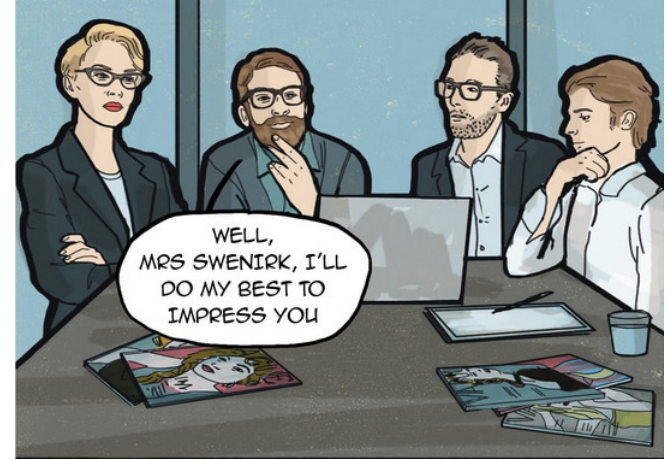
Figure 1: Protagonists and Drawing Style of the Fashion